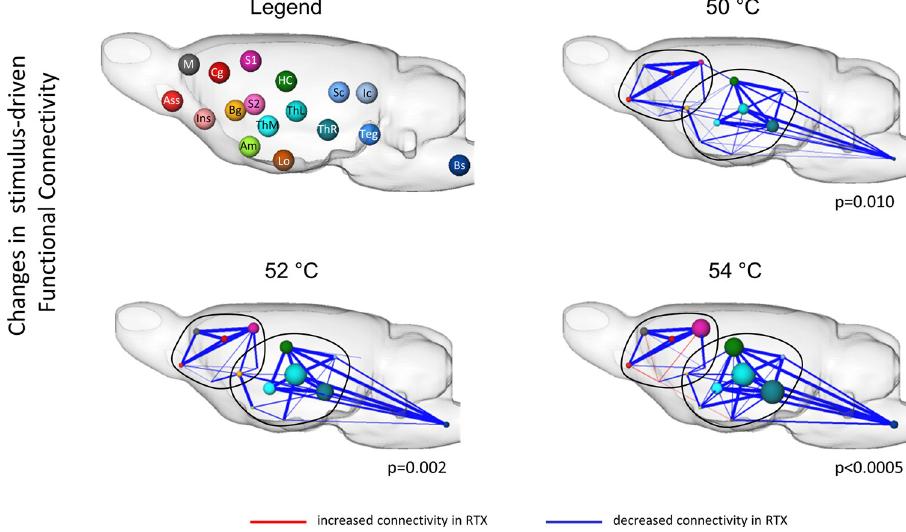
distinct subnetworks (encircled) of brain structures described below showed significantly decreased (blue edges) FC after RTX administration. While thalamo-cortical and hippocampal-cortical connections remained intact (no change), a great reduction was found between thalamus, hippocampus and brainstem such as the superior colliculi and, independently, within cortical structures (primary and sensory somatosensory cortex, association cortex and cingulate cortex). Different functional groups are distinguished by the node colors. Node size represents number of significantly different connections each node has to the others. Thickness of edges represents strength of connection (sum of Pearson r of all significantly different connections). Statistical significance was calculated using NBS, thereby correcting the p-value. (n Baseline = 18; n RTX = 9). Abbreviations: Am: amygdala; Ass: association cortex; BG: basalganglia (esp. striatum); Bs: brainstem structures; Cg: cingulate cortex; HC: hippocampus; Ic: inferior colliculi; Ins: insular cortex; Lo: limbic output/hypothalamus; M: motor cortex; S1/S2: primary/secondary somatosensory cortex; Sc: superior colliculi; Teg: Tegmentum; thM/L: medial/lateral thalamus; ThR: other thalamic